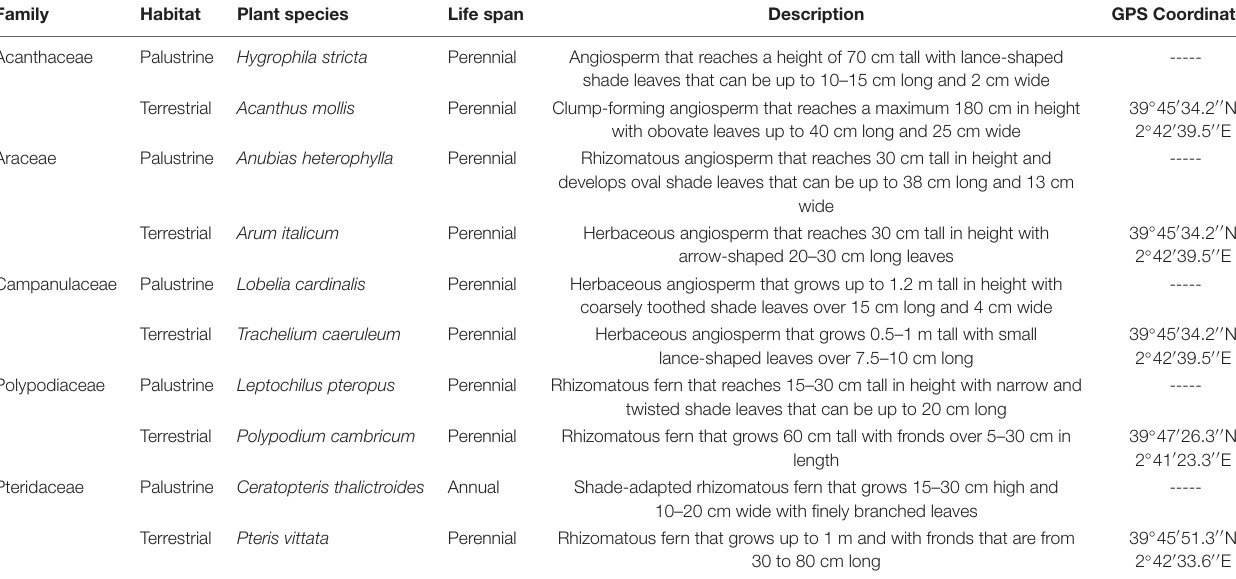
TABLE 1 | Classification, collection, and life histories of the different plant species used in this study. Family Habitat Plant